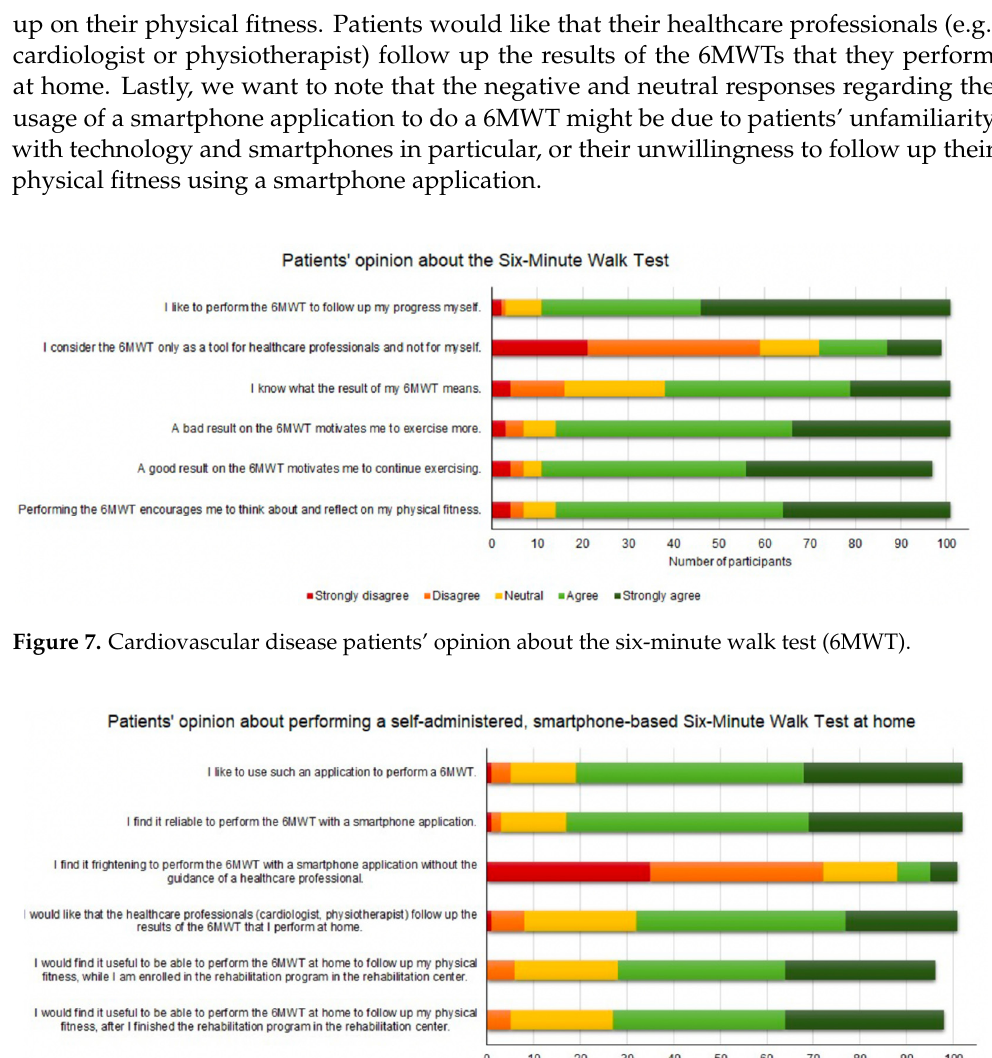
Figure 8. Cardiovascular disease patients’ opinion about performing a self-administered, smartphone-based six-minute walk test (6MWT).